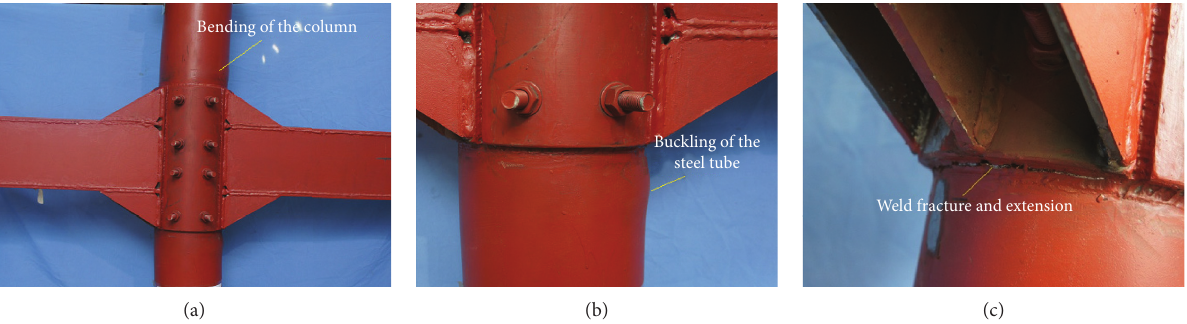
Figure 9: Failure modes of J-3: (a) column bending; (b) steel tube buckling; (c) weld fracture.